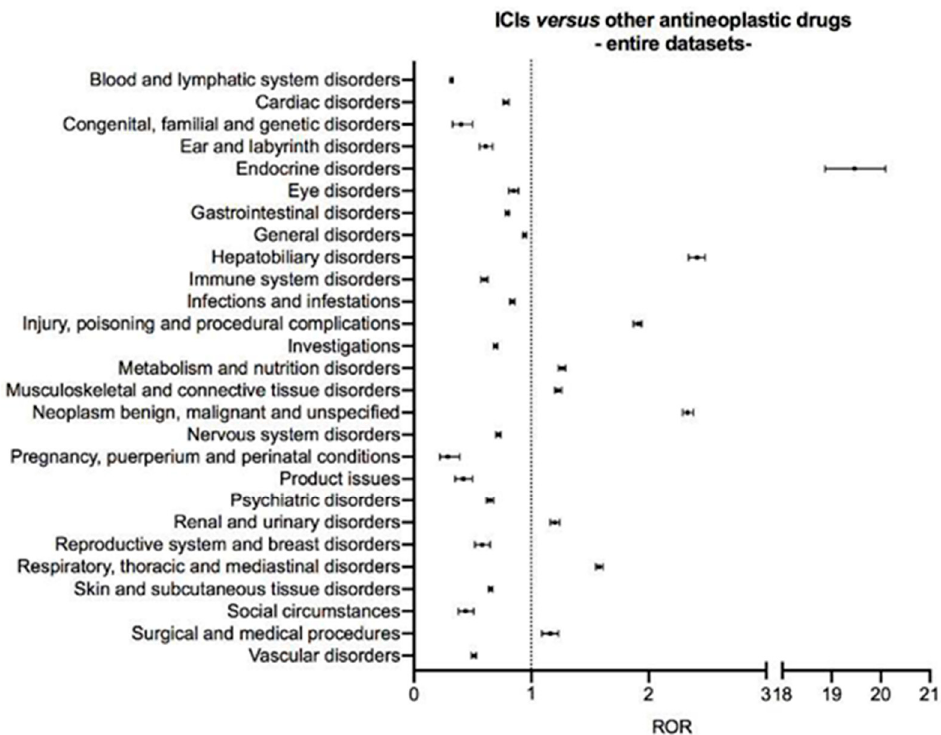
Figure 2. Disproportionality analysis on the entire datasets of safety reports associated with either immune checkpoint inhibitors or other antineoplastic drugs, without age restrictions and including safety reports lacking information on patient age. Suspected adverse drug reactions were clustered according to the Medical Dictionary for Regulatory Activities (MedDRA) System Organ Classes, version 23.0. Vertical bars on the ROR estimates indicate the 95% confidence intervals. Abbreviations: ICI, immune checkpoint inhibitor; ROR, reporting odds ratio.